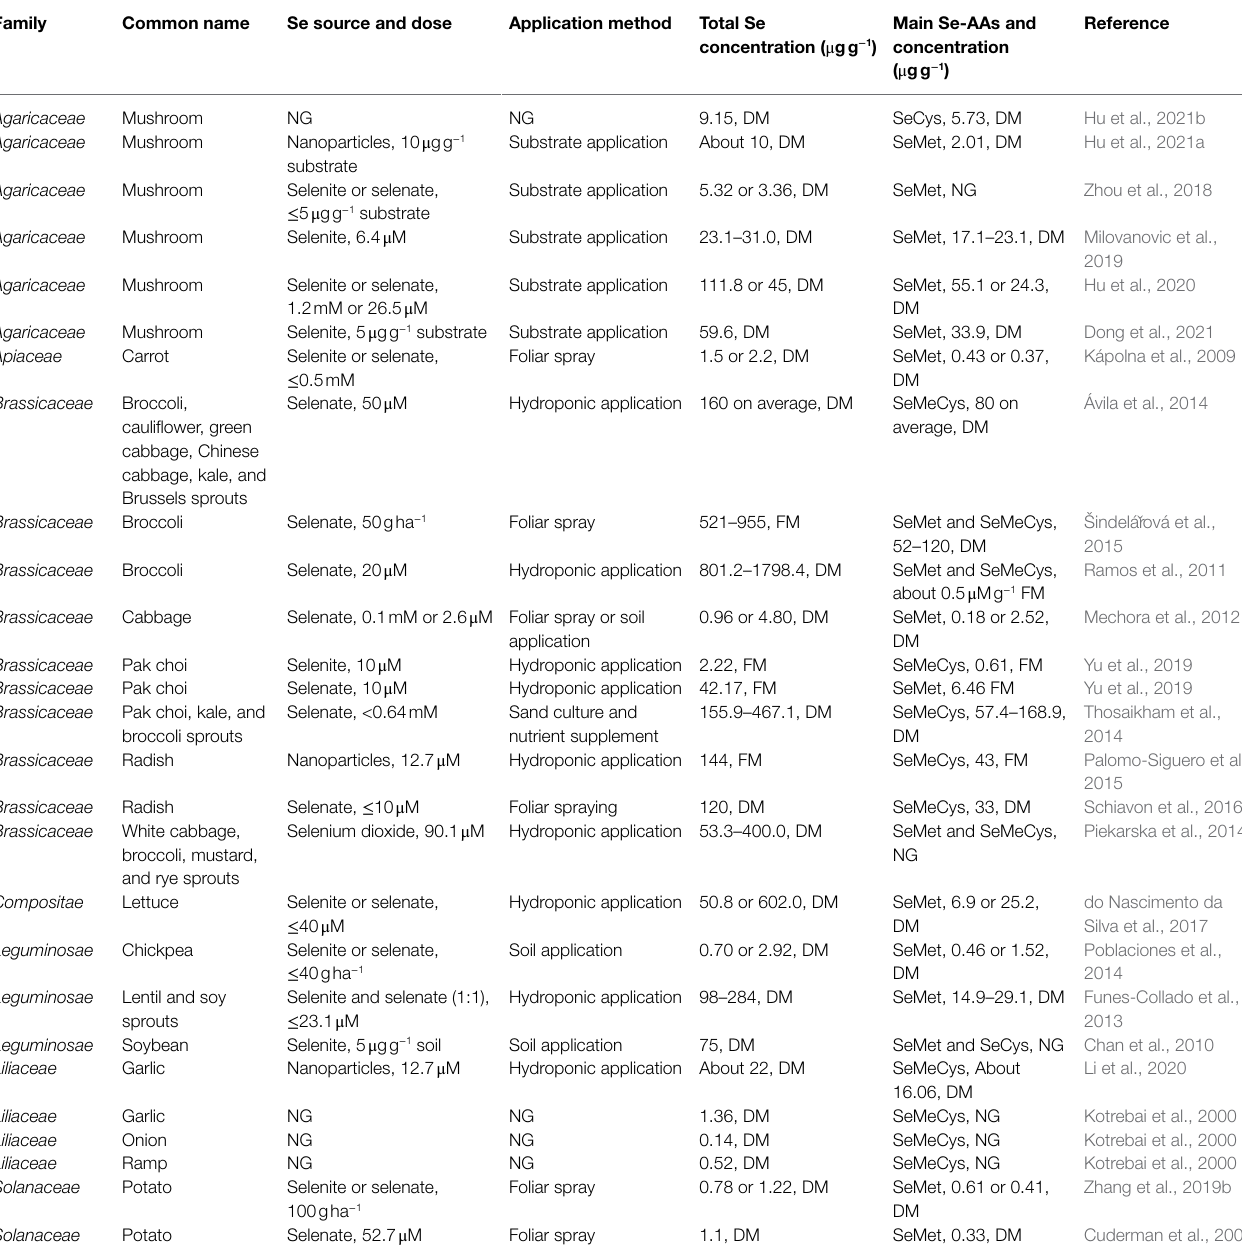
TABLE 1 | Concentrations of total selenium and the main seleno-amino acids in the edible parts of vegetables and mushrooms biofortified with